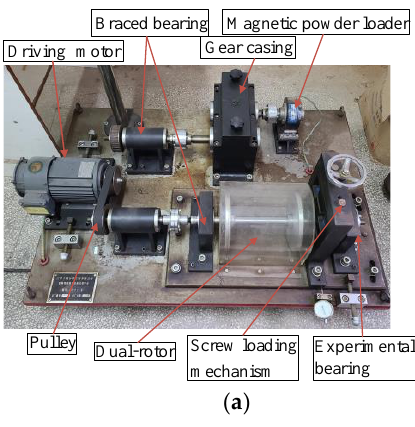
Figure 5. Experimental platform: ( a ) The test bench; ( b ) photographs of defective components under study.